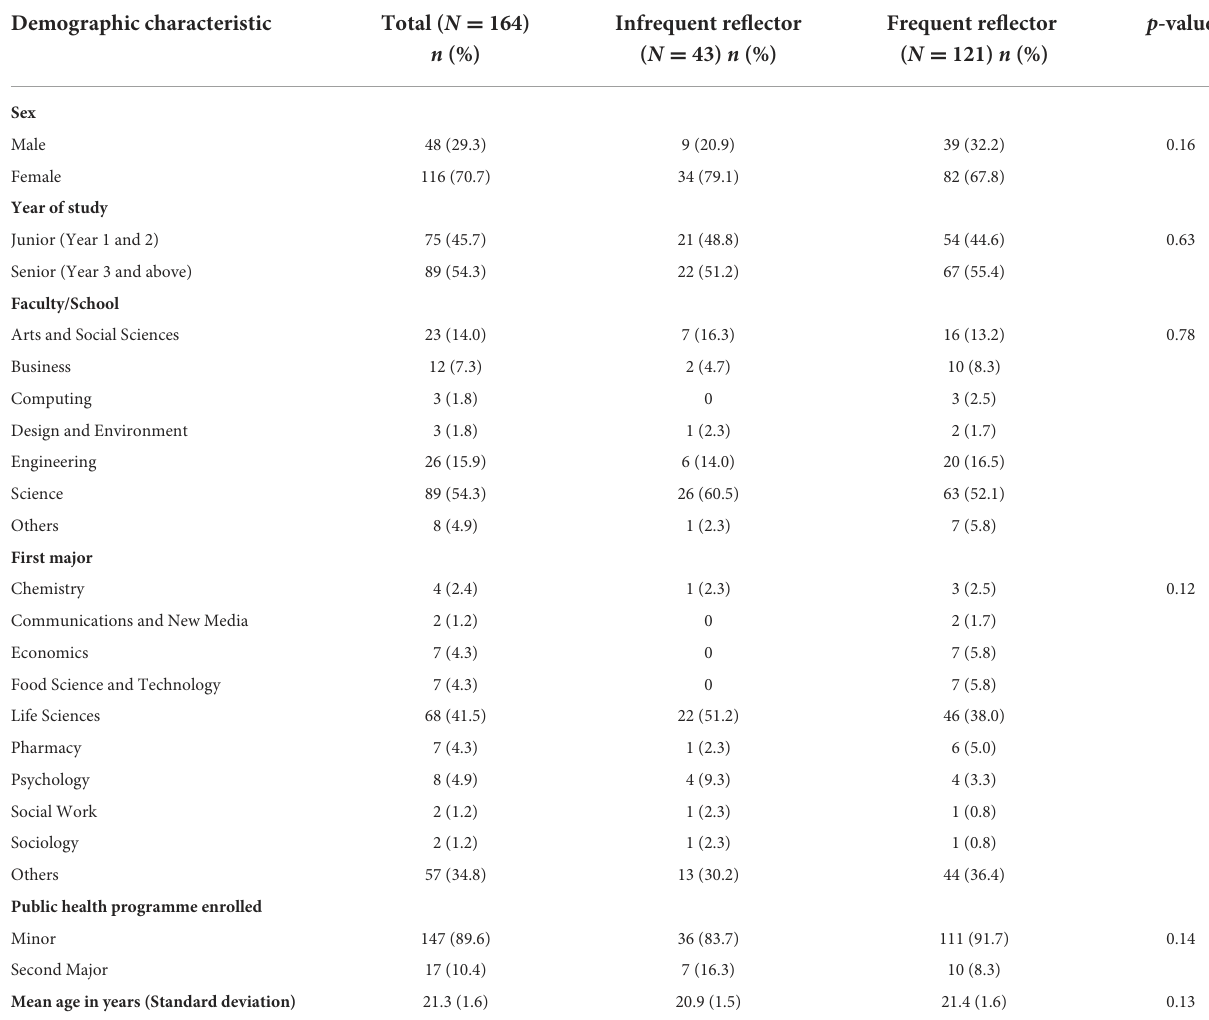
TABLE 1 Demographic characteristics of survey